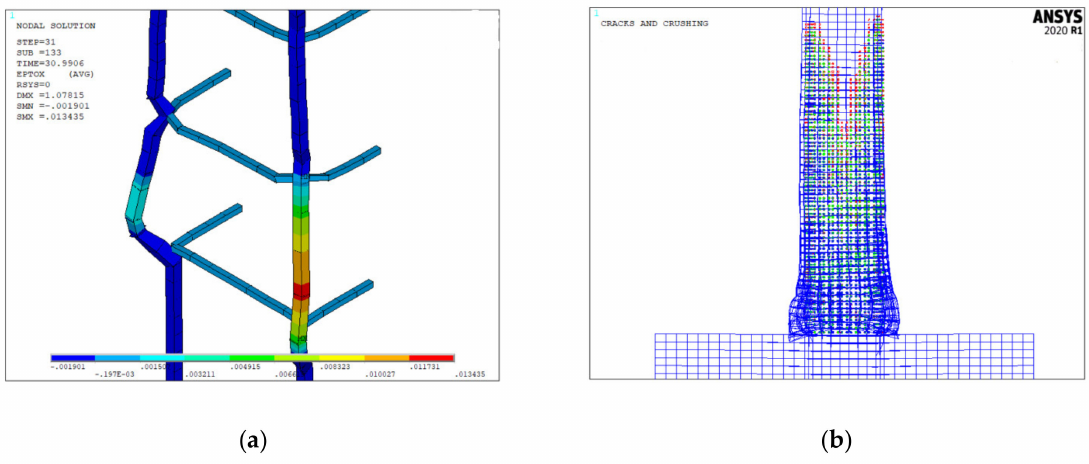
Figure 5. ( a ) Reinforcement buckling of the control column at failure; ( b ) cracks in the concrete at